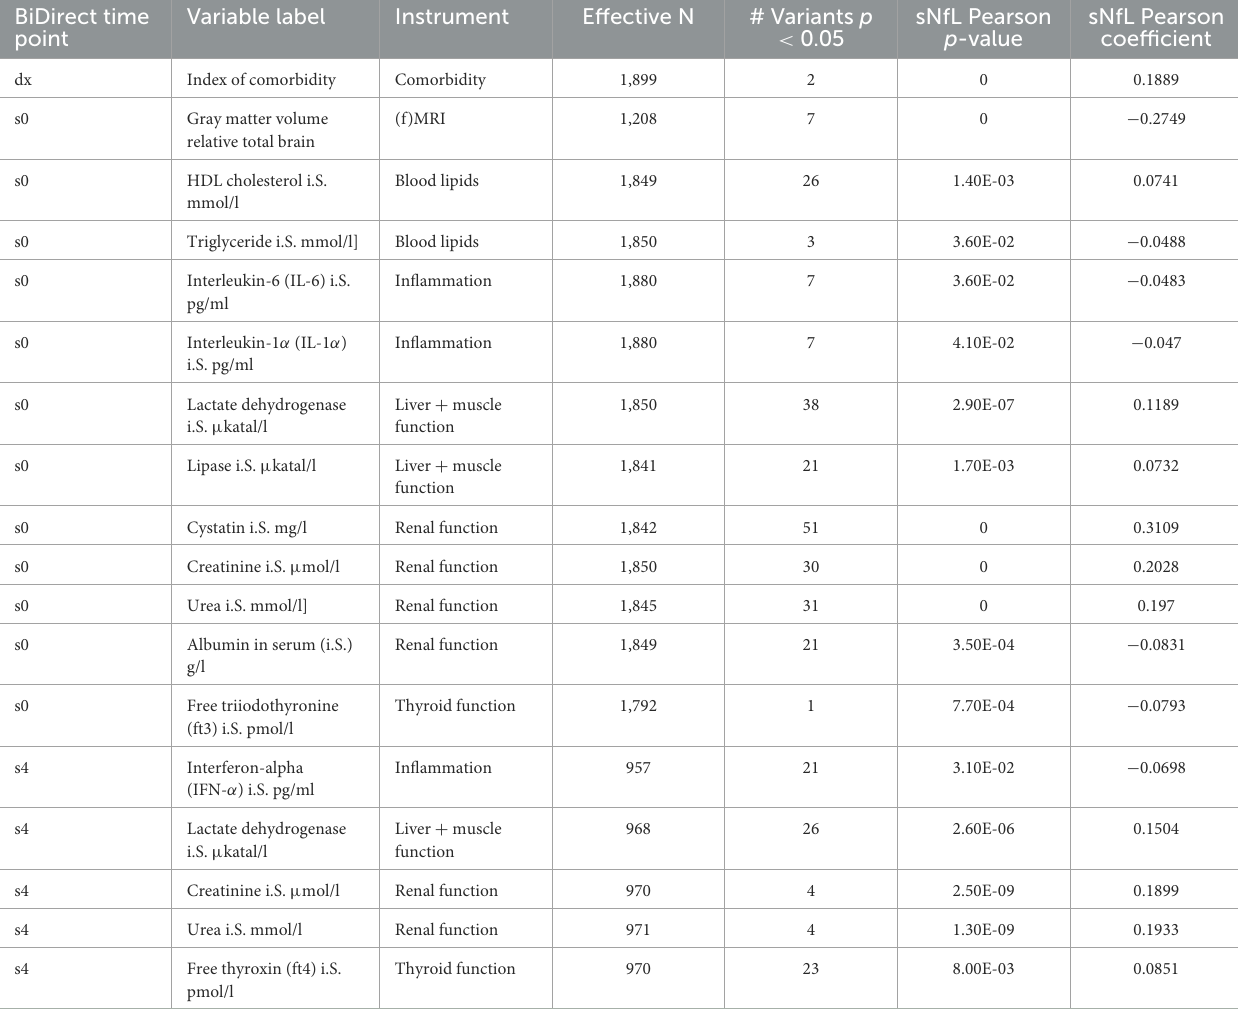
TABLE 4 Prioritized clinical variables in BiDirect showed significant correlations with sNfL and the GWAS meta-analysis loci. BiDirect time